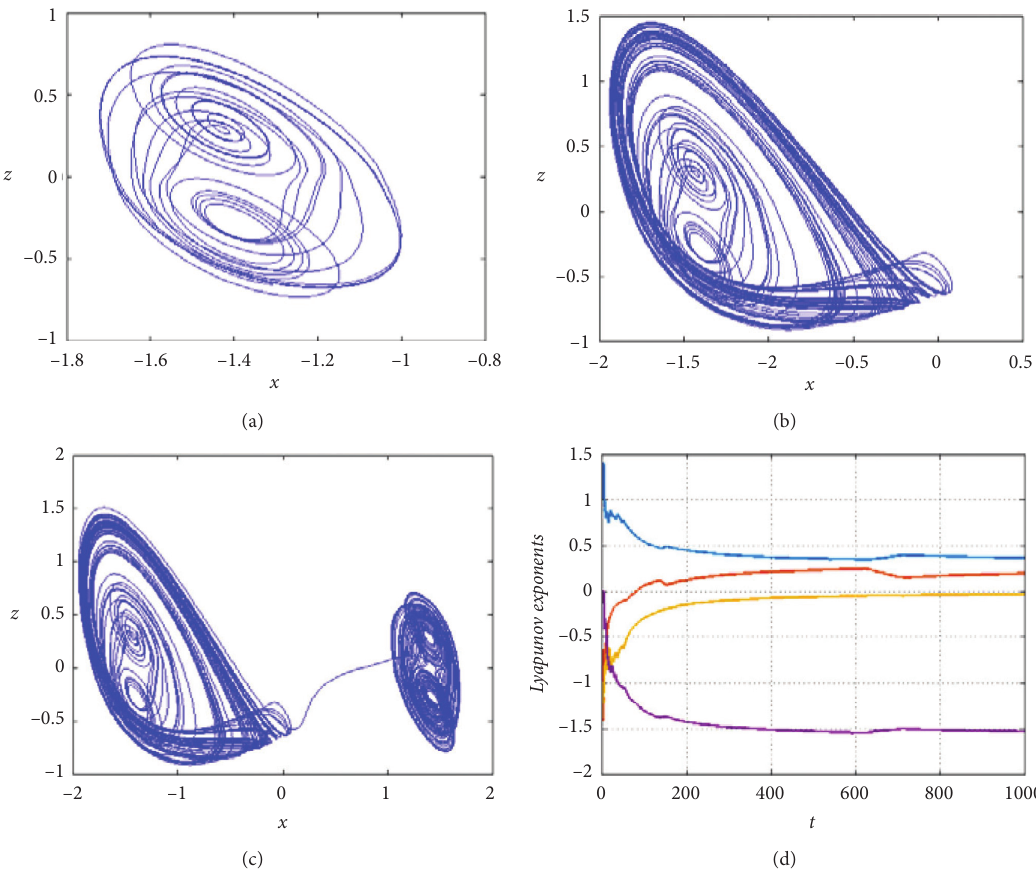
Figure 11: The transient transition behaviors with system (3). (a) A phase diagram of double-scroll hidden hyperchaotic attractors with t � 80 s. (b) A phase diagram of 3-scroll hidden chaotic attractors with t � 250s. (c) A phase diagram of 5-scroll hidden hyperchaotic attractors with t � 750s. (d) The Lyapunov exponent spectrum with increased time in the region of [0,